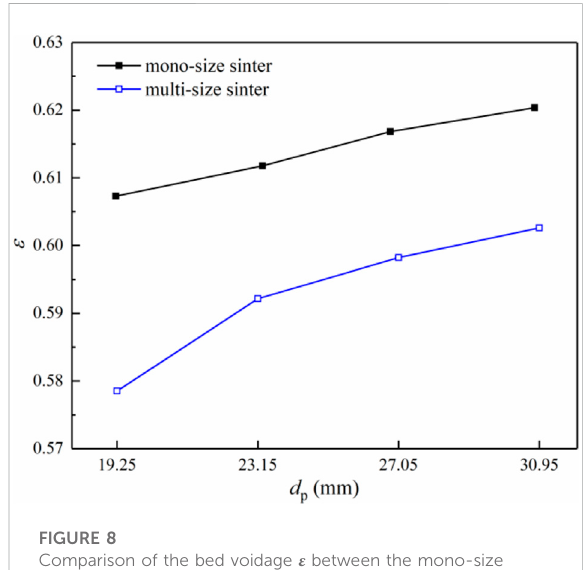
FIGURE 8 Comparison of the bed voidage ε between the mono-size sinter and multi-size sinter under the same equivalent particle diameter d p